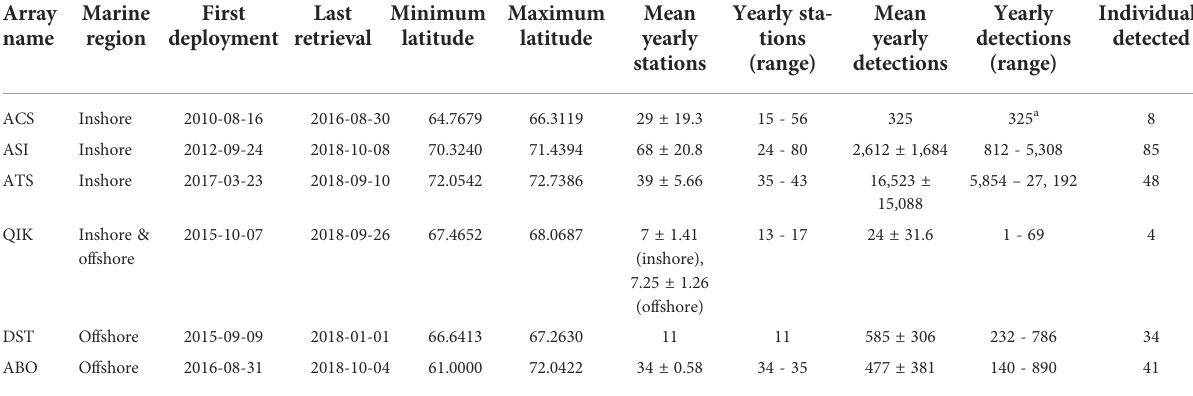
TABLE 1 Summary data for 6 acoustic receiver arrays in the Arctic-OTN array